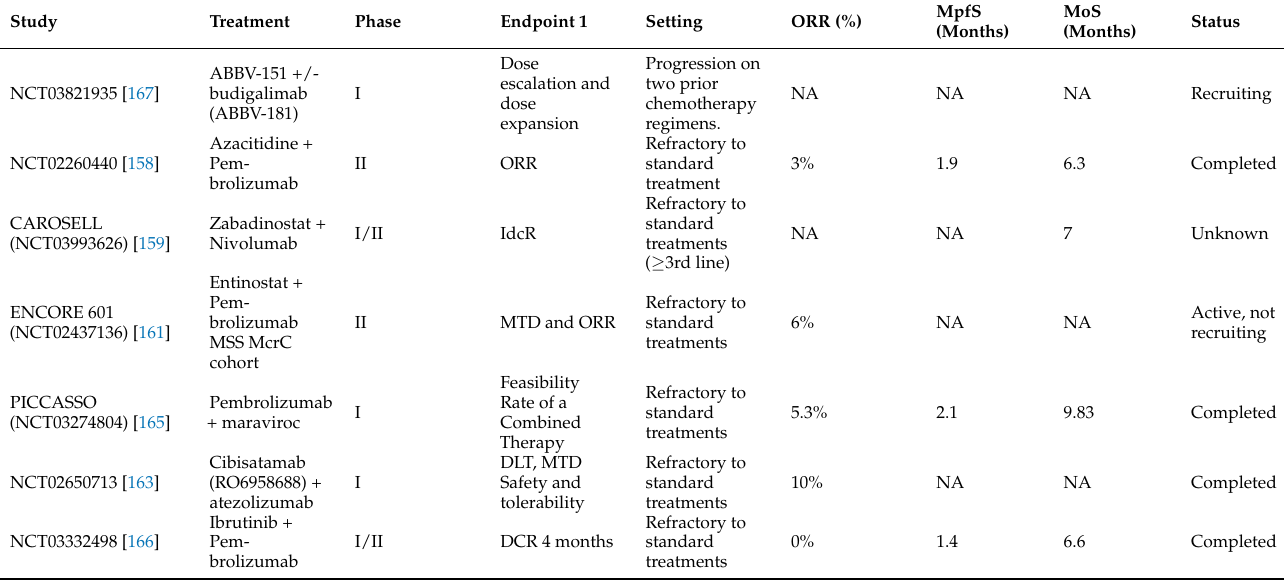
Table 11. Clinical trials involving novel blocking therapies plus ICIs in MSS